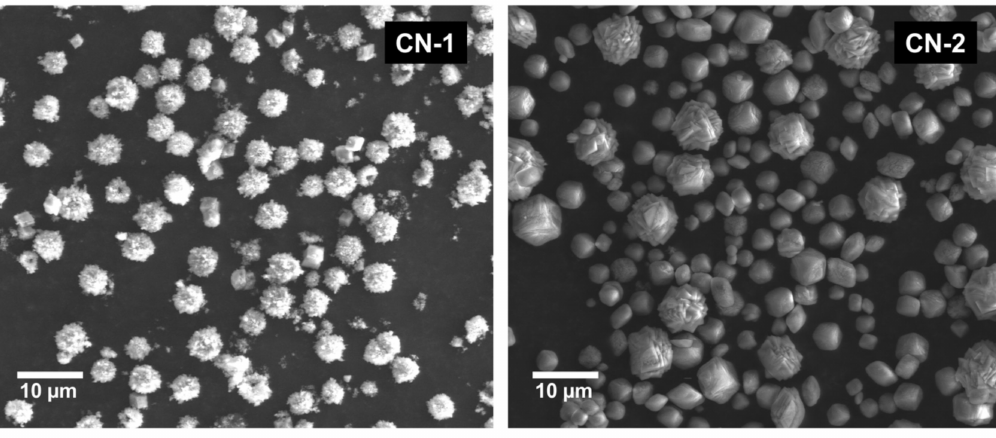
Figure 2. SEM images of CN-1 ( Left ) and CN-2 ( Right ) CaCO 3 -based